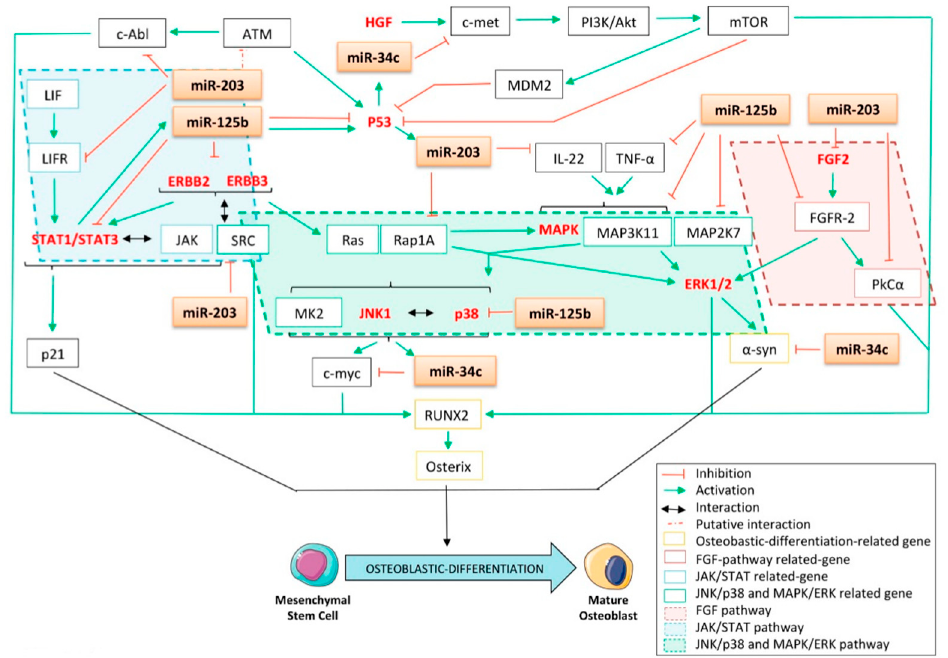
Figure 6. The p53-related miRNAs’ interplay with the fibroblast growth factor (FGF), the epidermal growth factor (EGF), the Janus kinase / signal transducer and activator of transcription (JAK / STAT), the C-jun N-terminal kinase / p38 (JNK / p38), the mitogen-activated protein kinase / ERK (MAPK / ERK) pathway and the other kinases-related pathways. ATM: ataraxia telangiectasia mutated; α